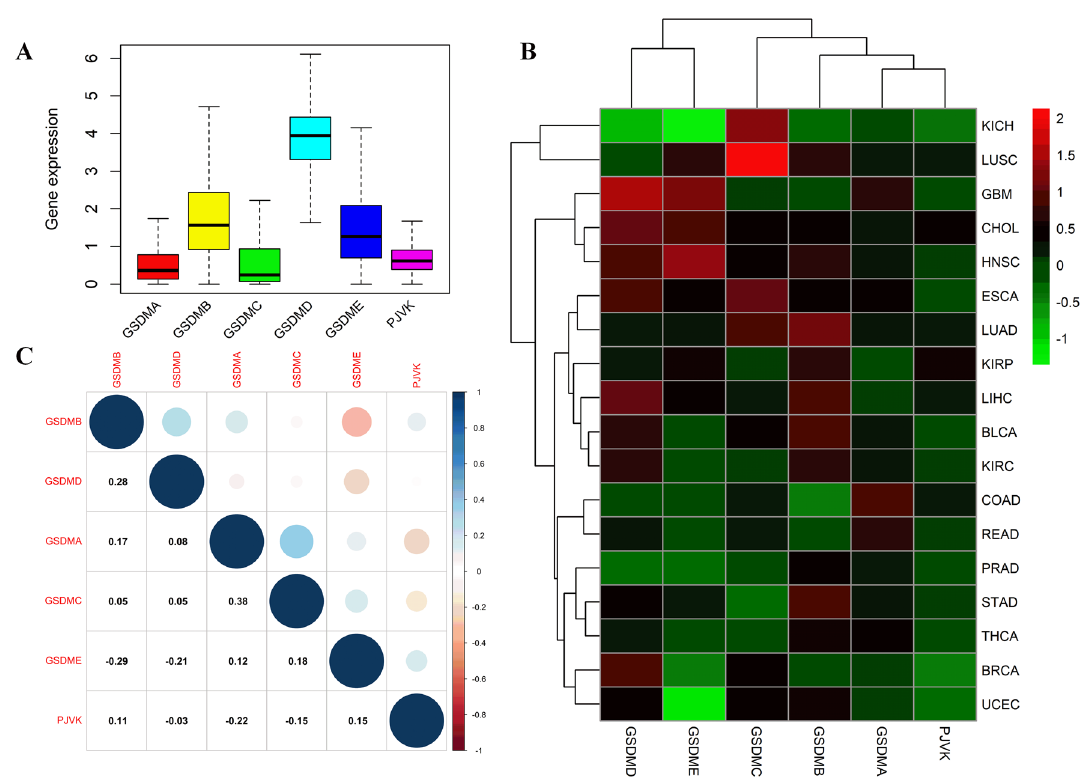
Figure 2. Gasdermin family gene expression levels and correlations across different cancer types from the TCGA database. The distinct expression of gasdermin family genes in various cancers ( A ). Heatmap depicting the expression differences of gasdermin family genes between tumor and surrounding normal tissues in different cancers. The red and green indicated the high or low expression, respectively. ( B ). The correlations among gasdermin family genes; Red dots represented negative correlations, whereas positive correlations were shown by blue dots ( C